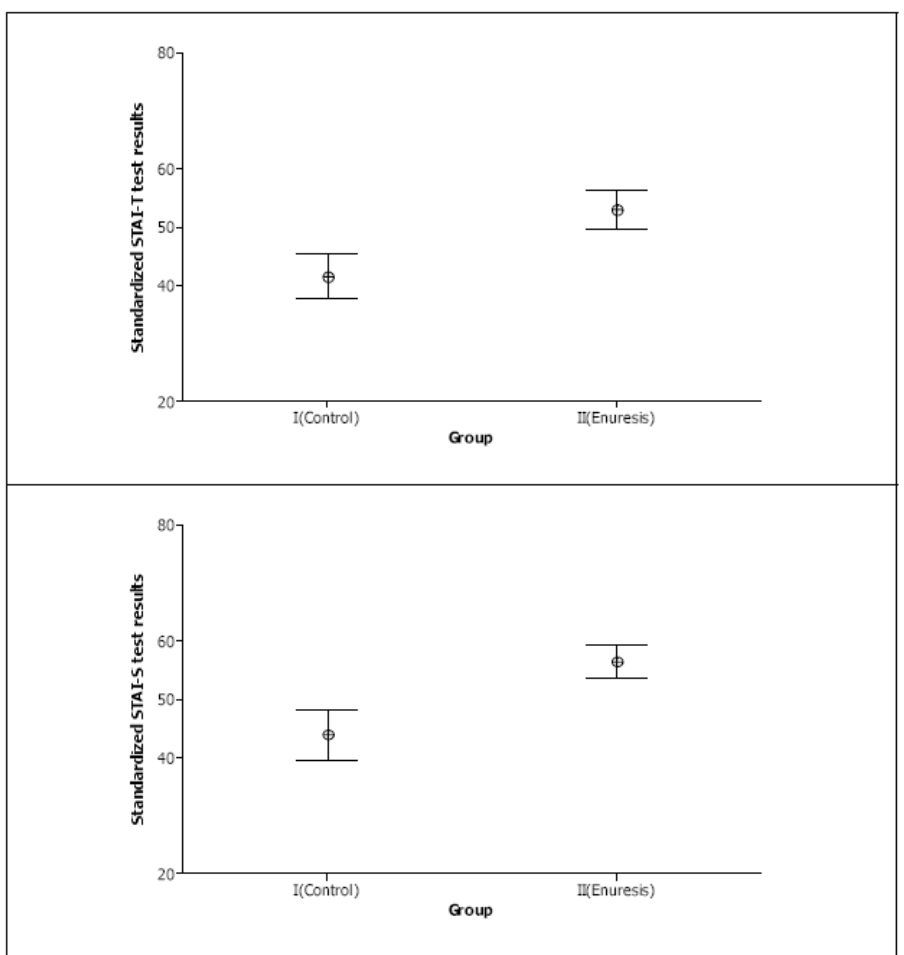
Figure 2. Standardized STAI-T and STAI-S test results. Group means are shown with 95% confi-